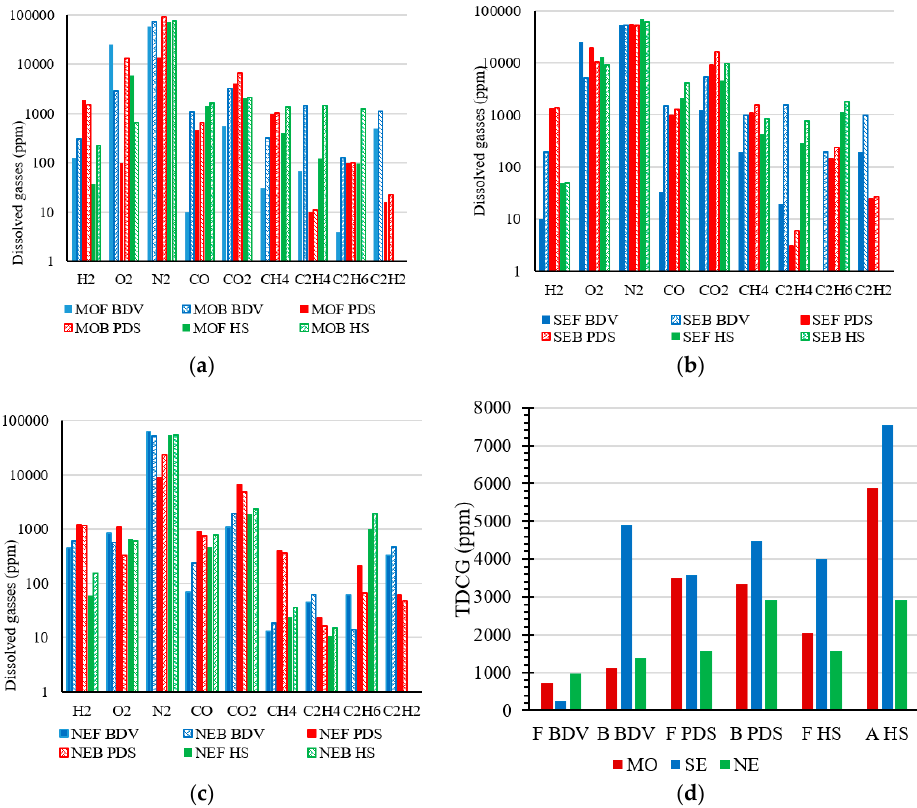
Figure 5. Illustration of the results of dissolved gasses under different fault conditions; ( a ) mineral oil; ( b ) synthetic ester; ( c ) natural ester; ( d ) total dissolved combustible gases.